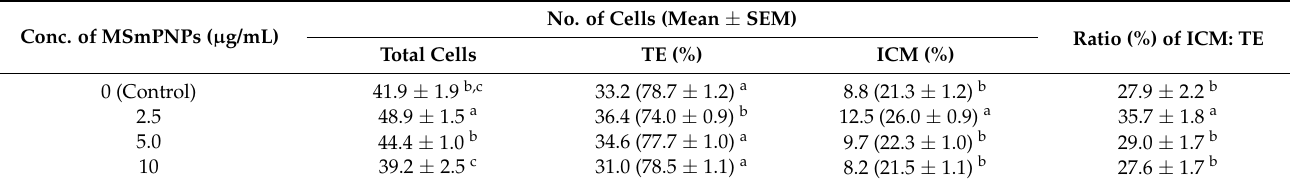
Table 5. Effect of in vitro maturation of porcine oocytes with different concentrations of MSmPNPs on different cell number of SCNT